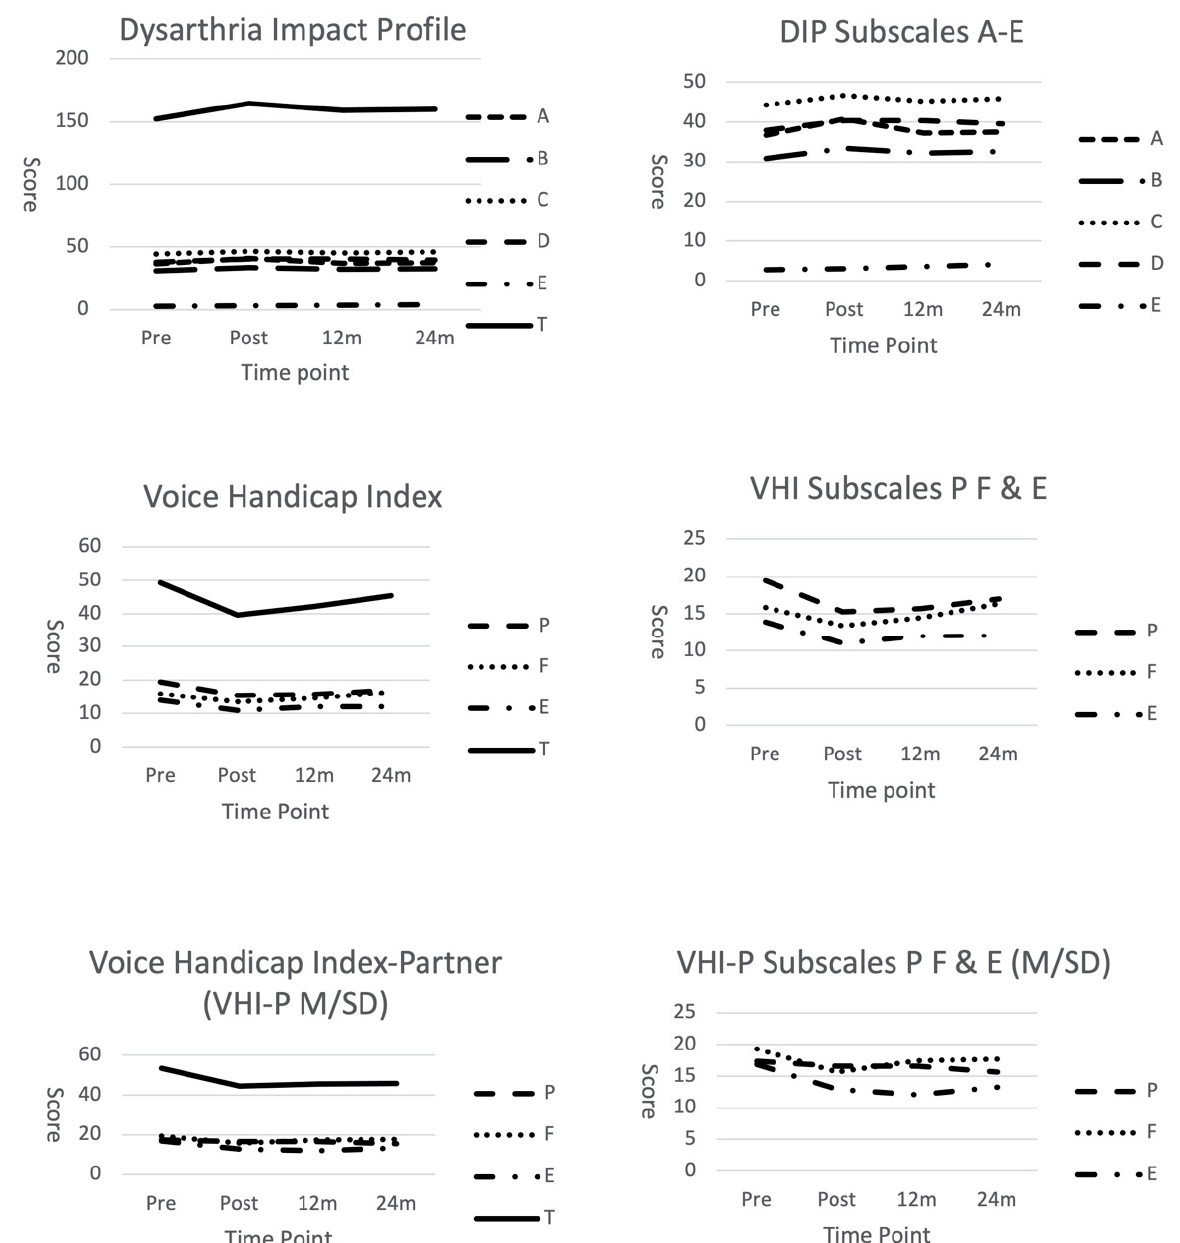
Figure 1. Mean total scores and subscale scores of Dysarthria Impact Profile, Voice Handicap Index, and Voice Handicap Index-Partner. Pre = pre-LSVT-LOUD; Post = post-LSVT-LOUD; 12 m = 12 months post-LSVT-LOUD; 24 m = 24 months post-LSVT-LOUD. Dysarthria Impact Profile [27]: higher score represents lessening of psychosocial impact. Voice Handicap Index [24]: lower score represents lessened perception of voice handicap. Voice Handicap Index-P [35]: lower score represents partners’ lessened perception of voice handicap.